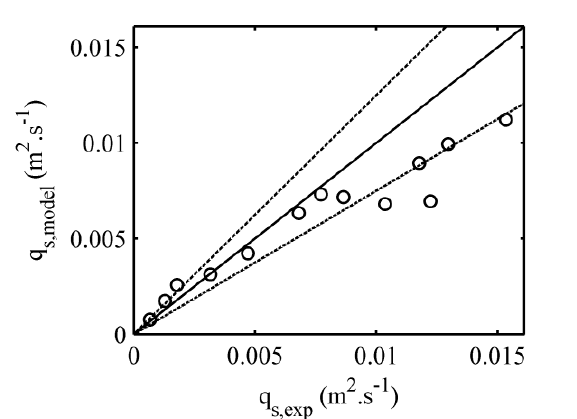
Fig. 15. Parity plot for experimental and predicted flow rate of sediment of FA60 flow. Legend: lines of perfect fit and of ± 25 per cent